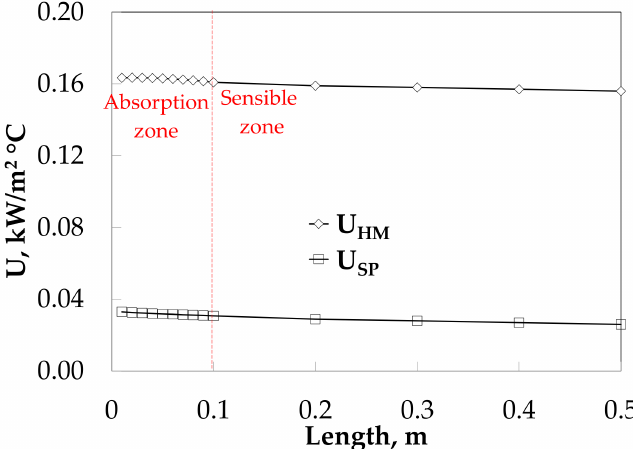
Figure 9. Overall heat transfer coefficient profiles along the absorber length with an HM.